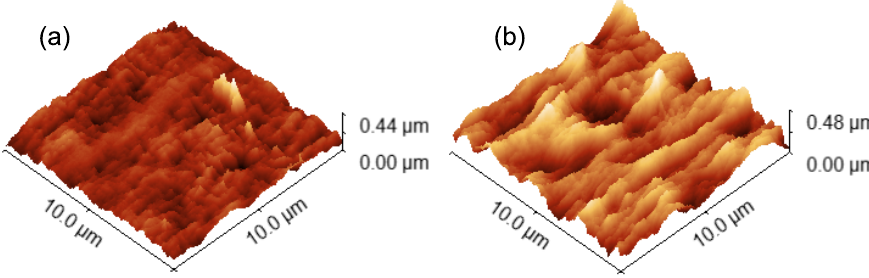
Figure 4. Atomic force microscopy (AFM) images of central channel surface. ( a ) Root mean square (RMS) roughness = 29.55 nm (grain masked for roughness calculation) (ID10); ( b ) RMS roughness = 68.58 nm (ID20). For detailed parameters see Table